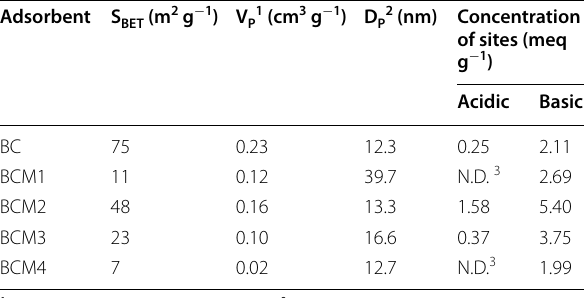
Table 2 Textural and physicochemical properties of BC